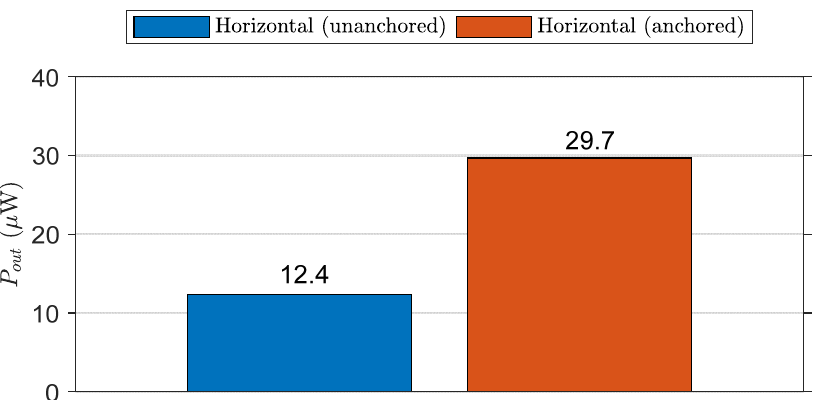
Figure 10. The horizontal one-sided anchoring (schematics not to scale). ( a ) Schematic of the one-sided anchored OWEC. ( b ) Photographic image of the one-sided anchored OWEC.